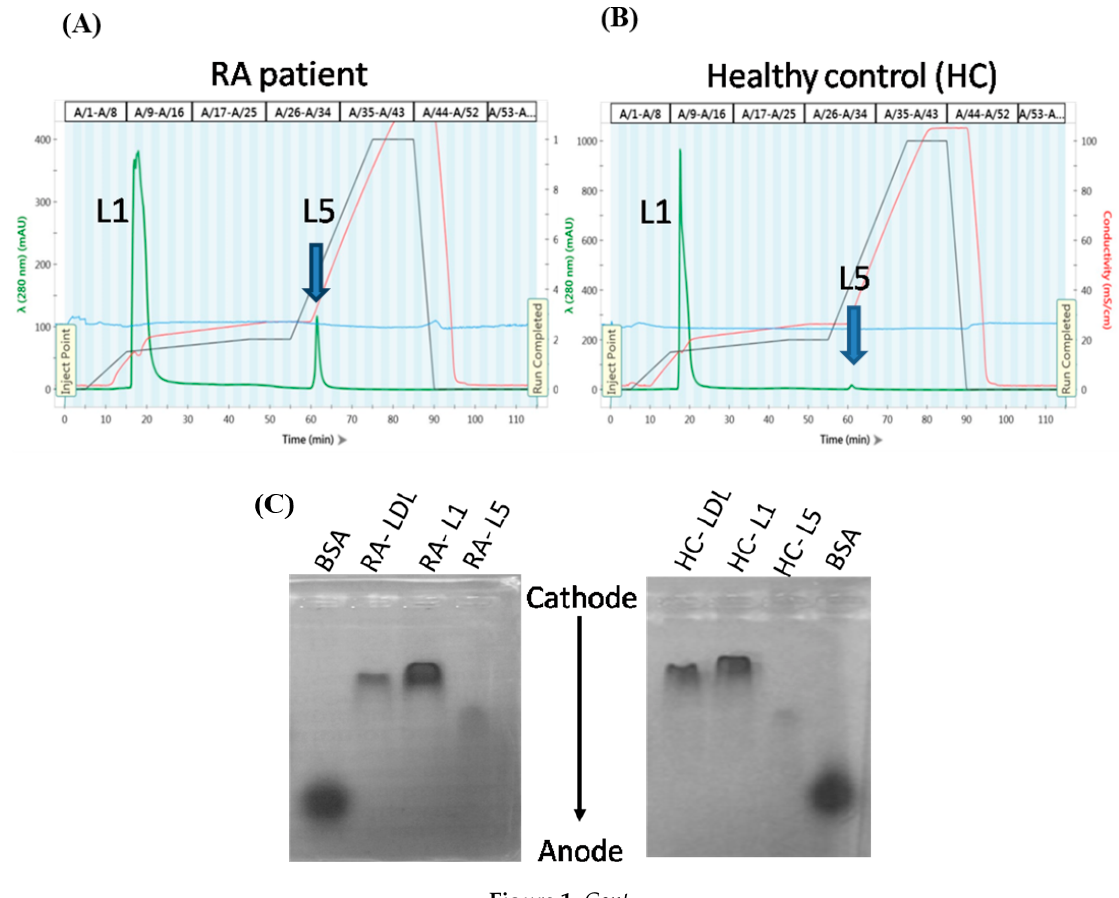
Figure 1. Cont Figure 1. Cont.